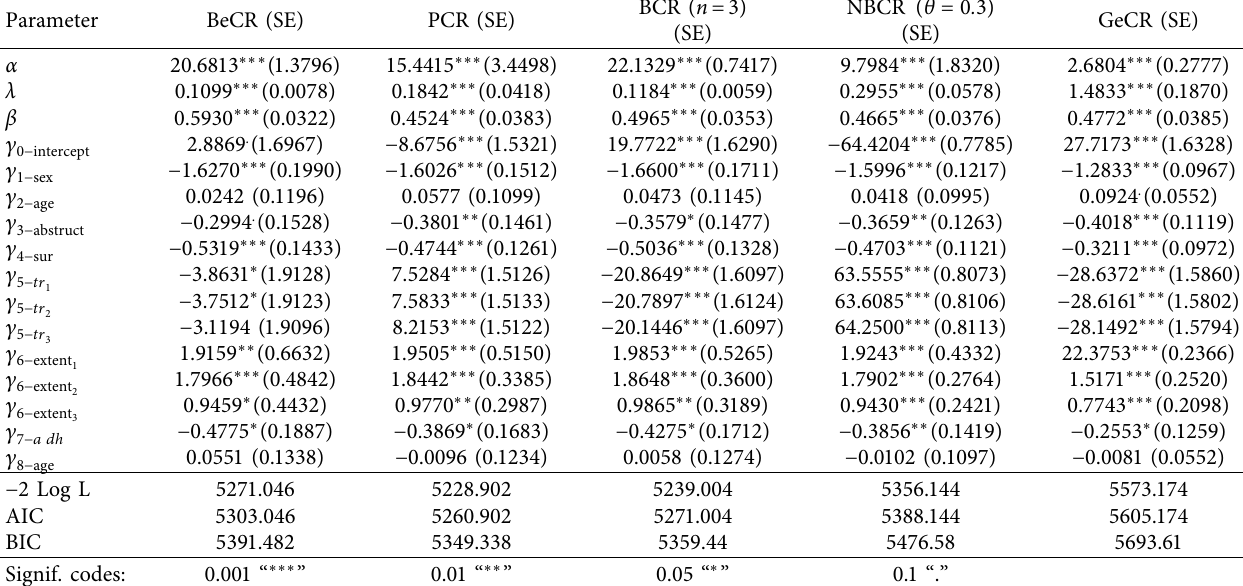
Table 4: ML estimators, standard errors (SEs), and information criteria for the colon cancer data set for diferent models. Parameter BeCR